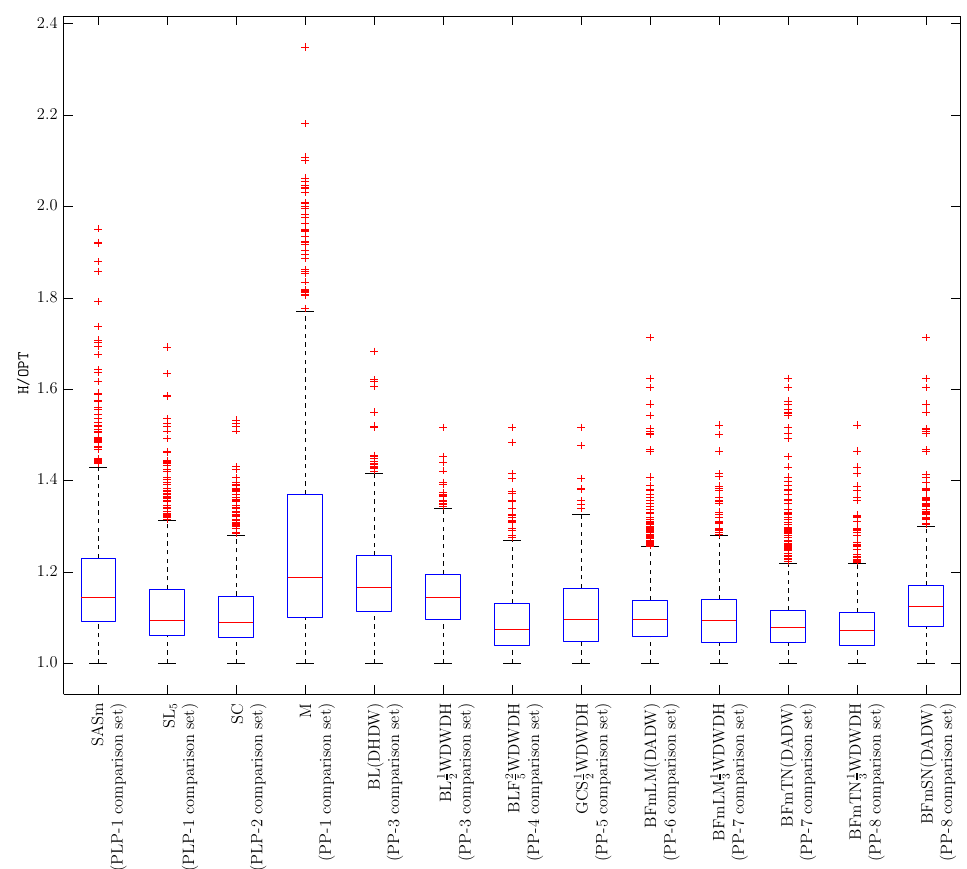
Figure 4: Box plots of the distribution of results achieved by the best pseudolevel and plane algorithms from each comparison set when applied to the 1 170 SPP benchmark instances listed